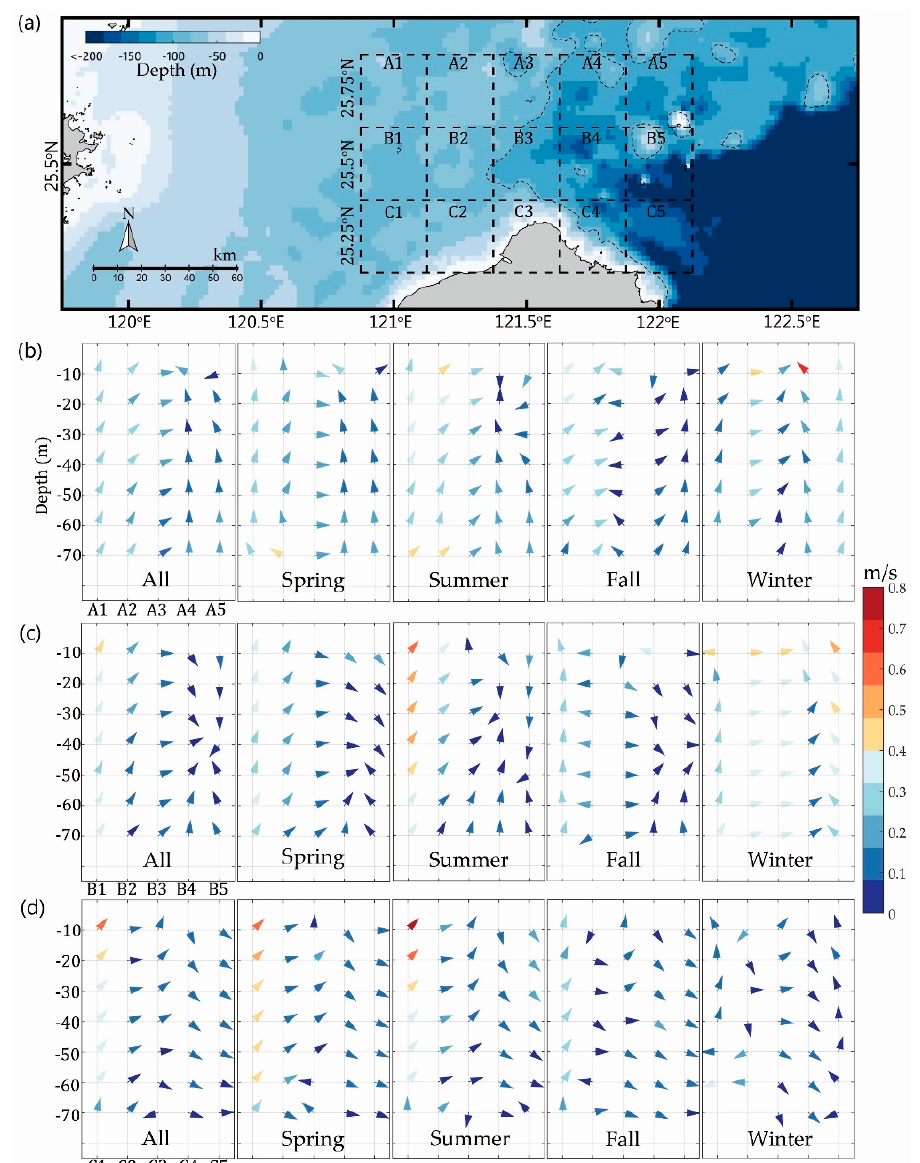
Figure 3. Multi-year statistics and seasonal results of the vertical profile (10–70m depth) of ocean currents in northern Taiwan: ( a ) Fifteen specific analysis locations, ( b ) areas A1 to A5, ( c ) areas B1 to B5, and ( d ) areas C1 to C5.